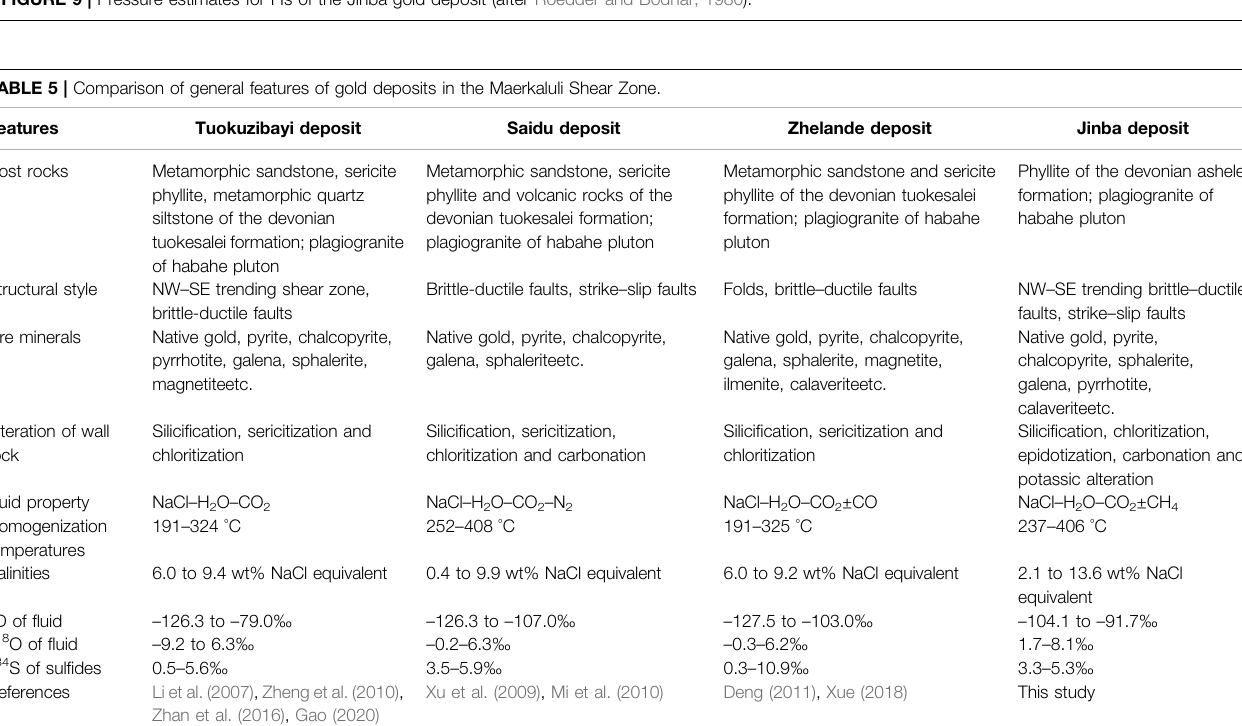
FIGURE 9 | Pressure estimates for FIs of the Jinba gold deposit (after Roedder and Bodnar, 1980).